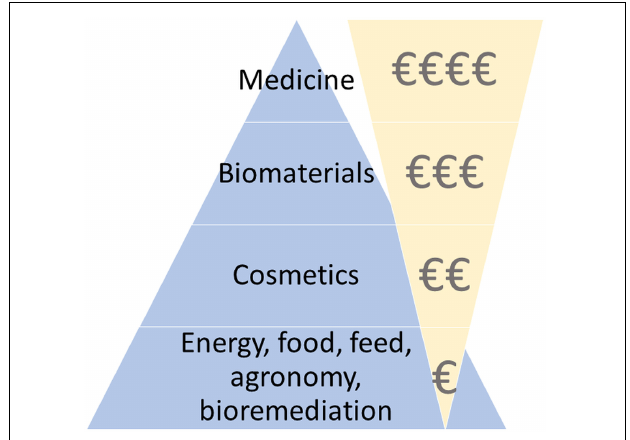
FIGURE 4 | Marine biotechnology products pyramid values. Adapted from Day et al. (2016). The price/quantity ratio is depicted by the areas of the